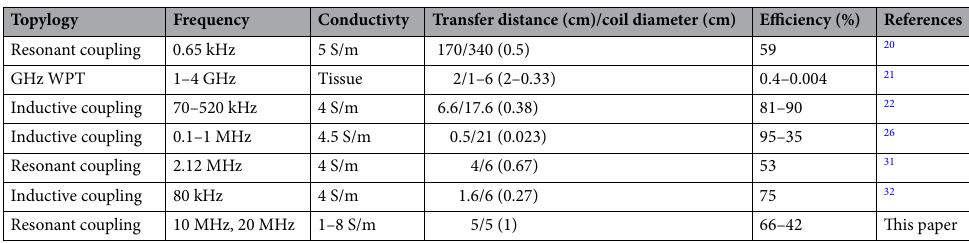
Table 1. Performance comparisons of WPT system in conducting medium.